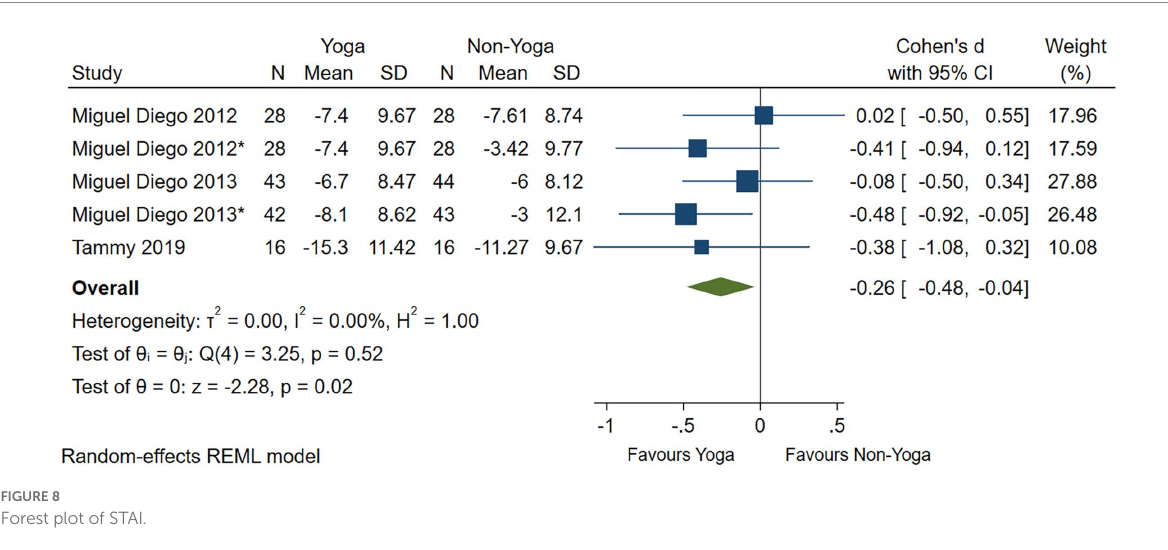
FIGURE 7 Forest plot of HAMA.